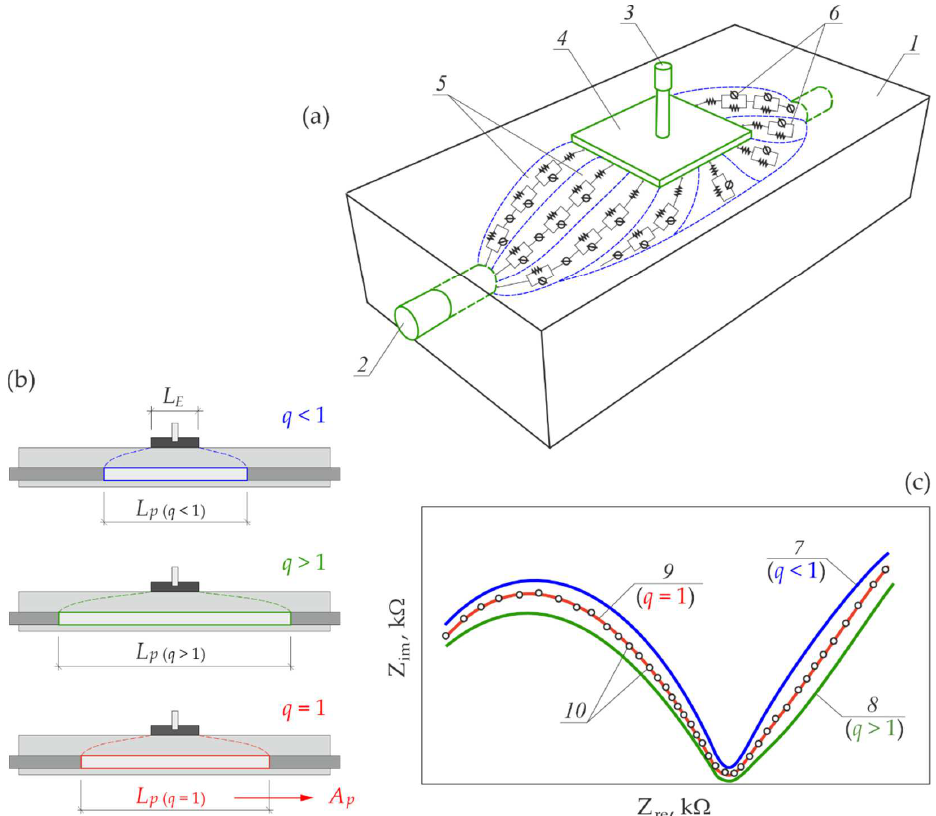
Figure 10. Schematic presentation of the iterative methodology for determining the polarized area of reinforcement in concrete using the 3D model : ( a ) main assumptions for the 3D model presented in a visual form: 1—concrete, 2—rebar, 3—reference electrode, 4—counter electrode, 5—theoretical paths of electrical conductivity of concrete, 6—basic electric equivalent circuits at each conductive path, ( b ) iteratively selected ranges L p of reinforcement polarization and corresponding factors q of matching degree of spectra, ( c ) shapes of model spectra 7, 8, 9 obtained in the complex plane according to the 3D model and corresponding factors q of the empirical degree of spectrum matching 10; based on the range L p determined for q = 1 calculated as the polarized area of reinforcement A p